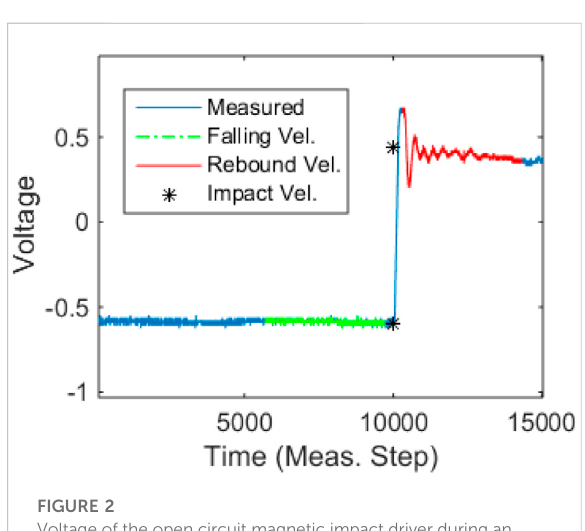
FIGURE 2 Voltage of the open circuit magnetic impact driver during an impact event occurring at approximately the 10,000th measurement time